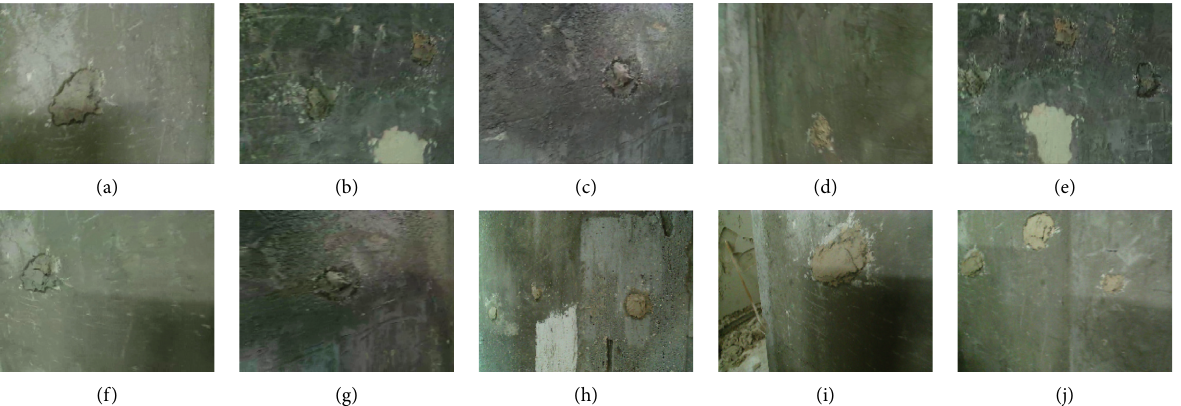
Figure 2: Some image samples of the wall defect dataset collected by the autonomous decoration robot. The image dataset is collected in real building decoration environments and need not require handcrafted bounding boxes: (a) Img-000, (b) Img-055, (c) Img-082, (d) Img-108,